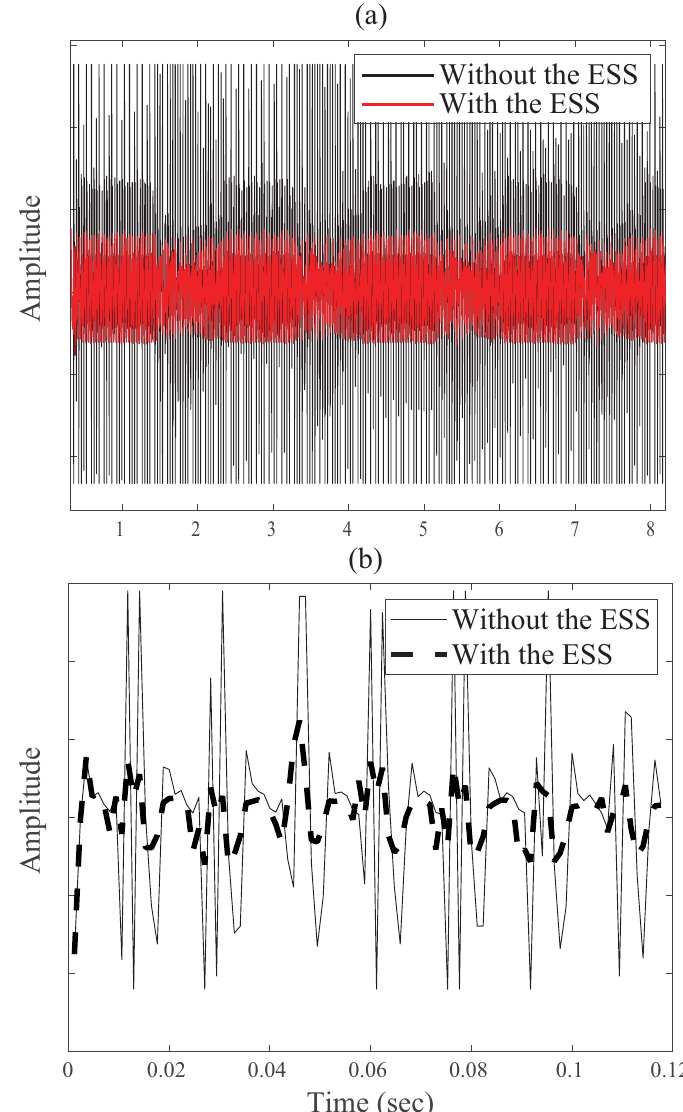
Figure 6. Result of the ESS-preprocessing method. ( a ) Entire plot of the result, ( b ) Magnified plot of the